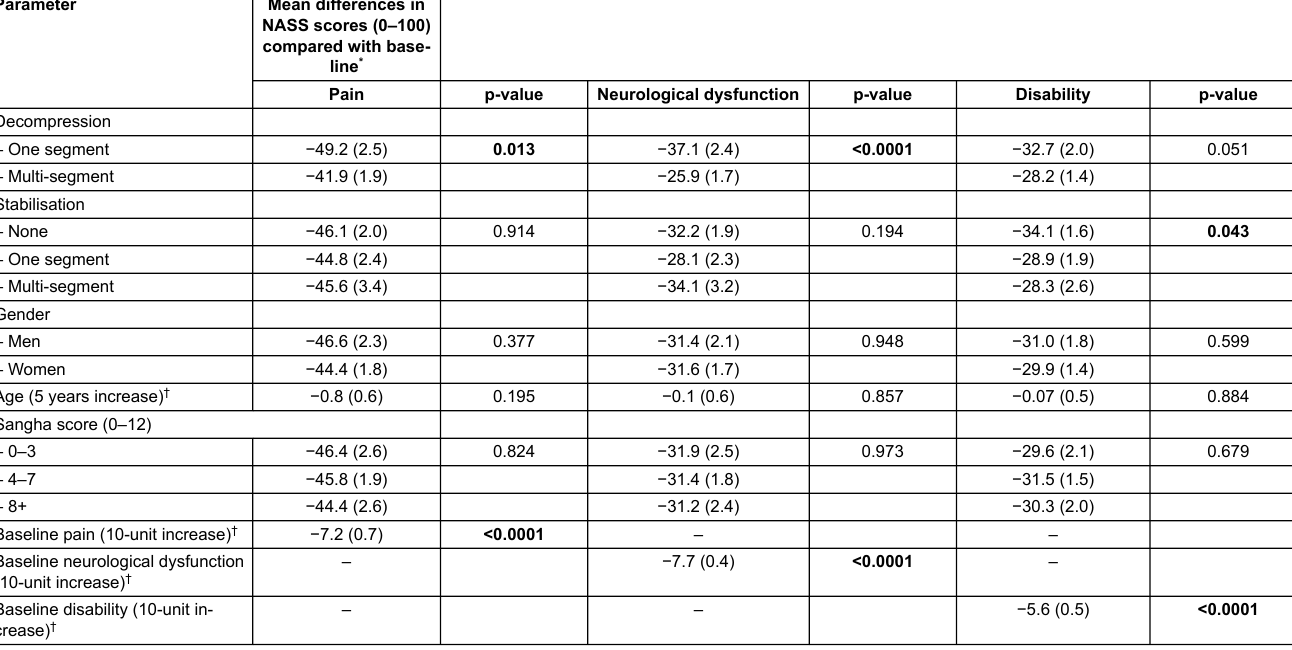
Table 3: Overall change in repeated NASS outcomes over 12 months after spinal stenosis surgery by type of surgery and other covariates. Parameter Mean differences in NASS scores